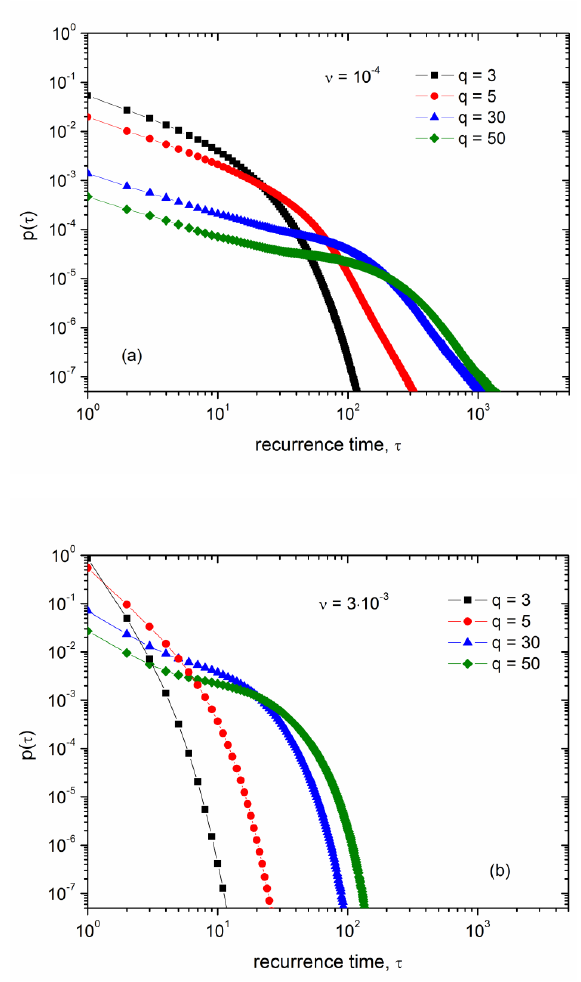
Fig. 2. Recurrence time distribution p(τ) for different values of the Figure 2. Recurrence time distribution p (  ) for different values of the threshold q , obtained by 4 threshold q , obtained by driving the system towards instability with rates (a) ν = 10 − 4 and (b) ν = 0.003. In the simulations, the value driving the system towards instability with rates (a)  = 10 -4 and (b)  = 0.003. In the simulations, 5 of the conservation parameter C is kept constant, C = 0.4. the value of the conservation parameter C is kept constant, C = 0.4. 6